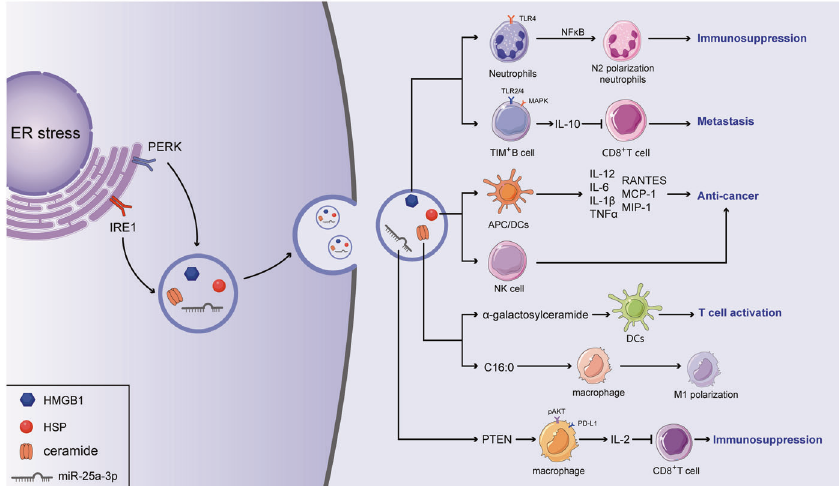
Fig. 2 ER stress regulate the secretion of EVs which contained immunomodulatory factors. In response to ER stress, ER stress transducers (IRE1 and PERK) facilitated the MVBs formation and boosted the EVs-mediated release of HMGB1, HPSs, ceramide, and miRNA. And HMGB1 has been reported to suppressed anti-tumor immune response by promoting the N2 polarization of neutrophils via activating the NF- κ B pathway. Moreover, HMGB1 has an inhibitory effect on CD8 + T cells by stimulating the expansion of the TIM-1 + Breg cells and increasing the expression of IL-10 through the MAPK and TLR 2/4 pathways. Exosomal HSP90, HSP70, and HSP60 have been indicated to promote the chemotherapy resistance of cancer cells. Nevertheless, Hsp72 activates the effect of NK cells, simultaneously promoting the release of in fl ammatory factors in APCs to stimulate the anti-cancer response. C24:1 and C18:0 ceramides promote chemoresistance in multiple cancer while alpha- galactosylceramide enhances T-cell-mediated anti-cancer response through the activated effect of dendritic cells. miR-23a-3p decreases the production of IL-2 and recedes the function of CD8 + T cells by inhibiting PTEN and then increasing the AKT-mediated PD-L1 expression in